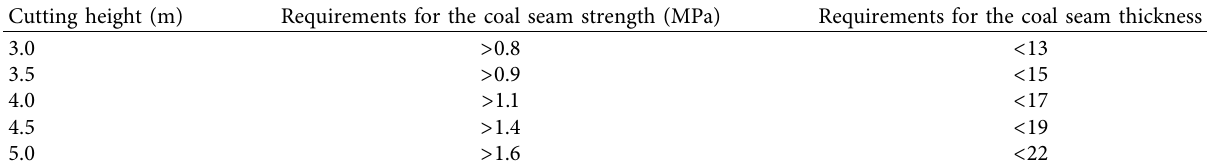
Table 2: Coal seam strength and thickness under different cutting heights.